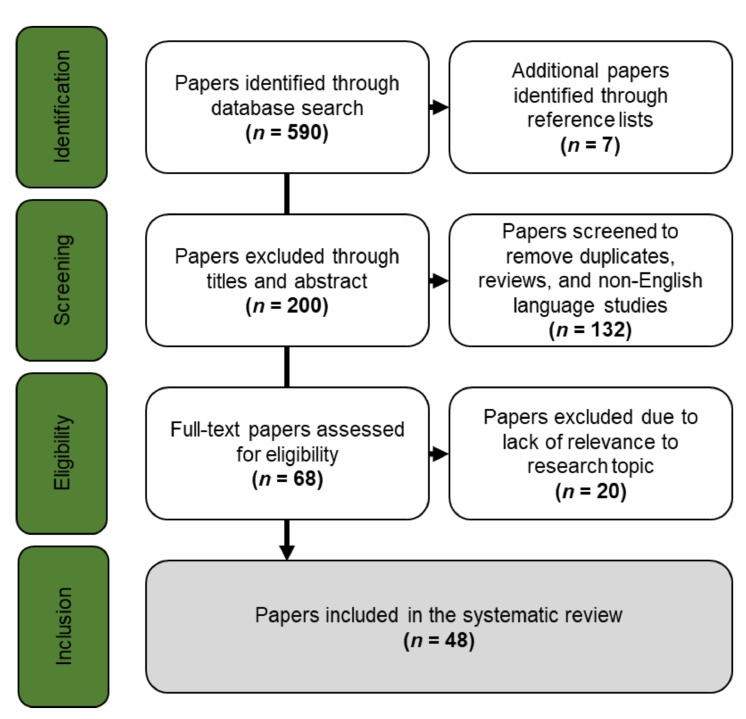
Figure 1. Selection process for the systematic literature